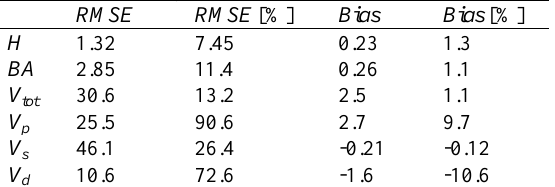
Table 1. Stand-level accuracy of mean tree height ( H ), mean basal area ( BA ), total stem volume ( V tot ) and stem volume by tree species; pine ( V p ), spruce ( V s ), and deciduous ( V d )